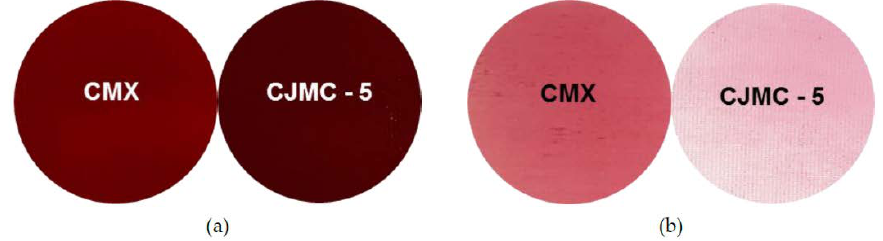
Figure 9. Photos of CMX and CJMC-5 samples after soaking in cranberry juice for 168 h ( a ) and subsequent soaking in 1 M NaCl solution for 24 h ( b ) for desorption of dyes.